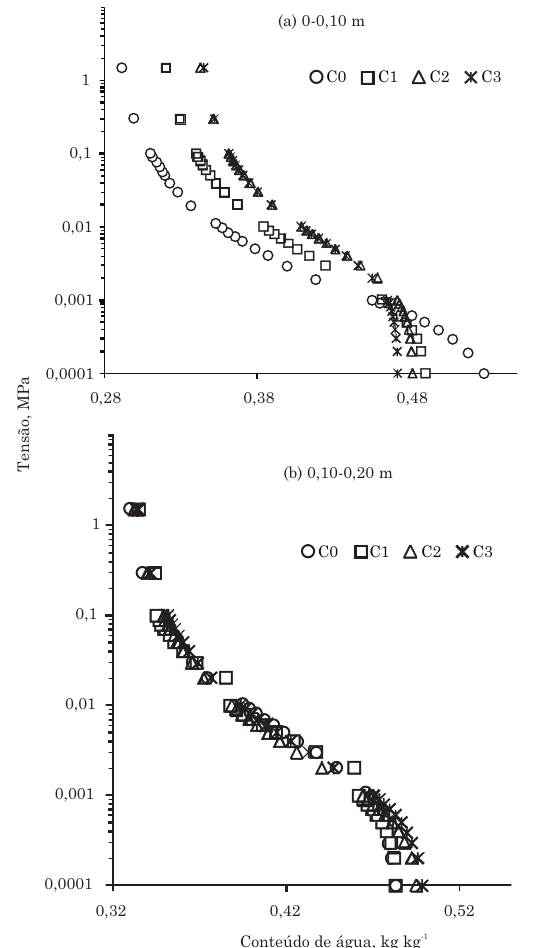
Figura 2. Curvas de retenção de água ajustadas pelo modelo proposto por van Genuchten